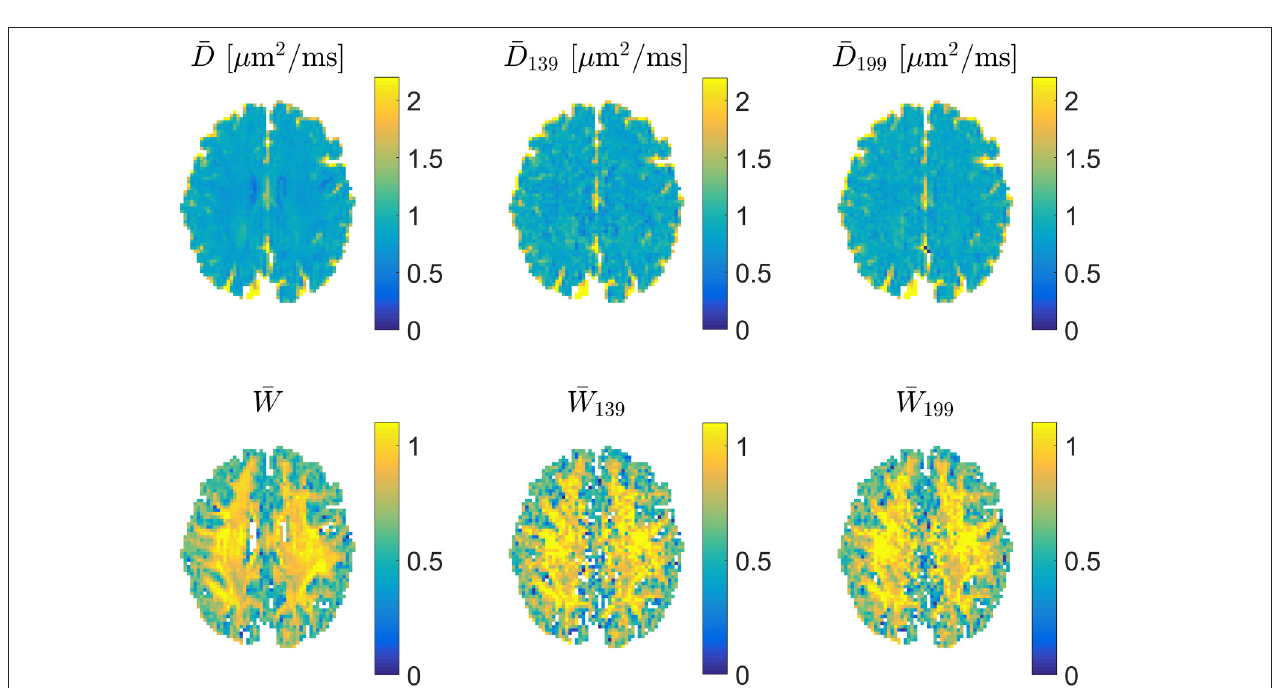
FIGURE 5 | Examples of estimates of mean diffusivity (Top) and W (Bottom) . In each row estimates were obtained (left to right) from a large DKI data set, a 1-3-9 acquisition, and a 1-9-9 data set. Figure adapted from Hansen et al. [41] with